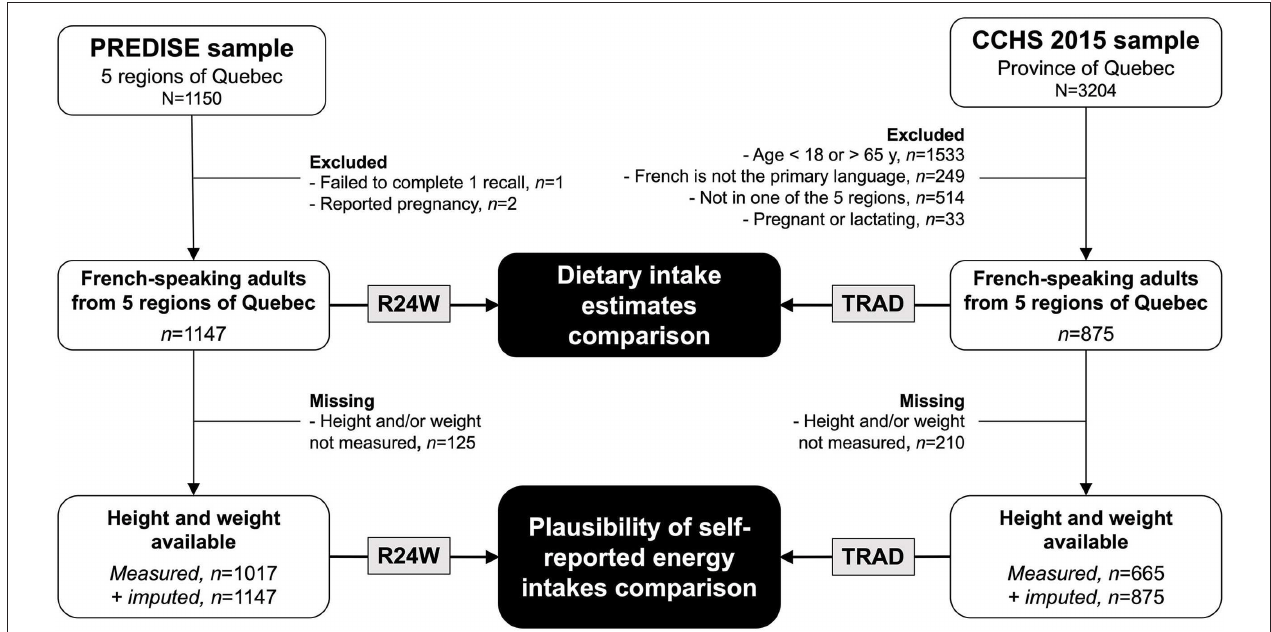
FIGURE 1 | Participant flow chart. CCHS 2015, Canadian Community Health Survey 2015. PREDISE, PRÉDicteurs Individuels, Sociaux et Environnementaux .